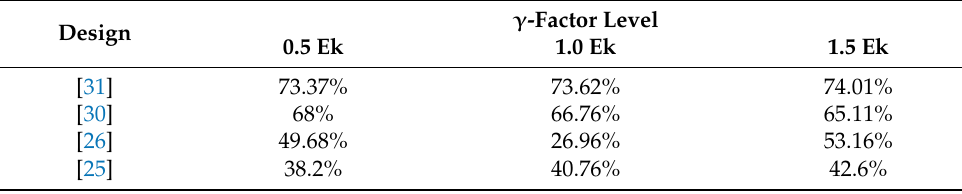
Table 5. Performance Improvement of Energy Dissipated by Proposed Memory